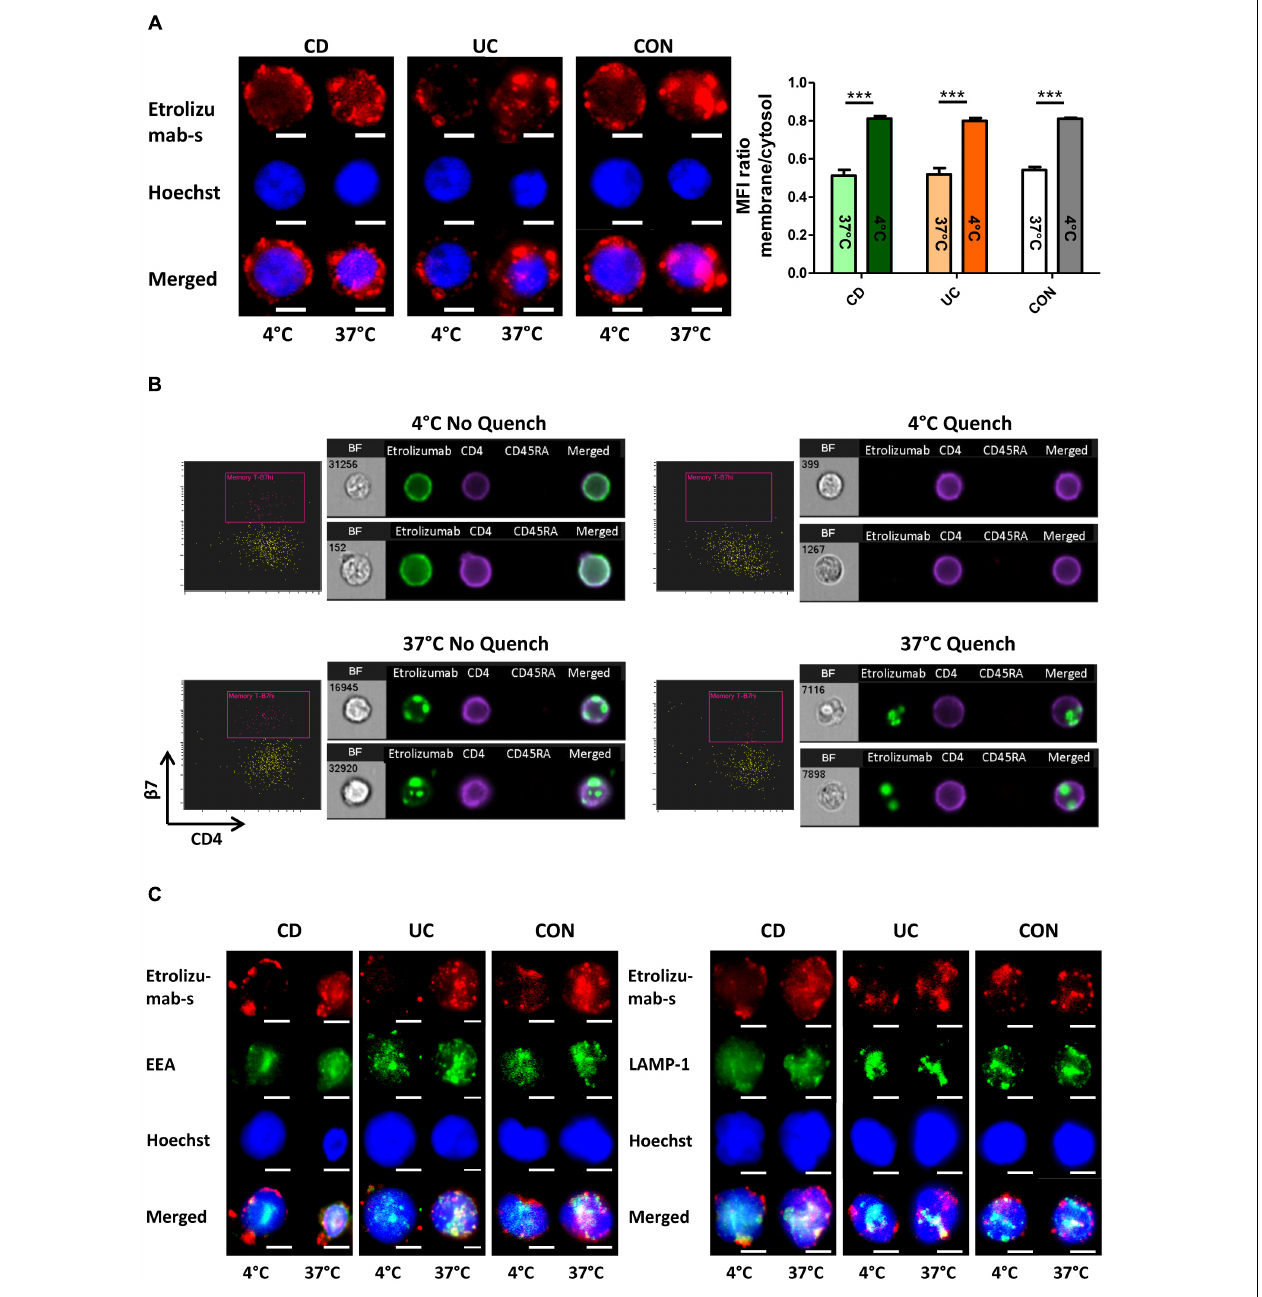
FIGURE 2 | β 7 integrin is internalized by treatment of lymphocytes with etrolizumab(-s). (A) Left: Representative images showing localization of the fluorescence signal of AF647-labeled etrolizumab-s after treatment of cells from CD, UC, and CON donors at 4 or 37 ◦ C for 24 h. Scale bar: 3 µ m. Right: Quantification of mean fluorescence intensity (MFI) of AF647 signal in the cytosol relative to the membrane at 4 and 37 ◦ C; n = 5 per group. ∗∗∗ p < 0.001. (B) Assessment of etrolizumab internalization with ImageStream R (cid:13) . Representative flow cytometry and microscopy results after cell incubation with AF488-labeled etrolizumab at 4 ◦ C (upper row) or 37 ◦ C (lower row) and without (left panels) or with (right panels) quench procedure. BF, bright field. Data are representative for two independent experiments with a total of eight samples. (C) Representative images showing localization of AF647 fluorescence signal of etrolizumab-s and AF488 fluorescence signal of EEA (left) and LAMP-1 (right) after cell treatment with etrolizumab-s at 4 or 37 ◦ C for 24 h. Scale bar = 3 µ m. Images are representative for three independent experiments.